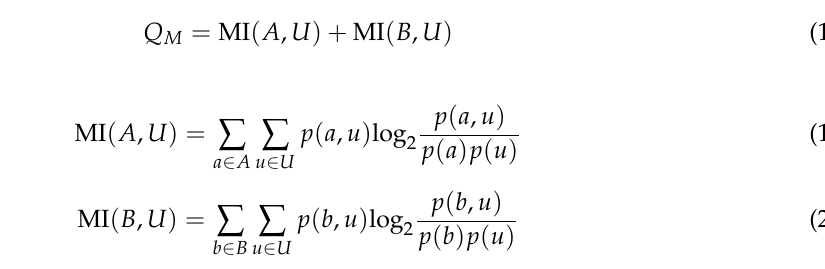
Figure 13. Enlarged views of fused results of ROIs denoted by the red boxes in Groups 7 and 8 shown in Figure 6 for the m-PCNN, SCM-F and SCM-M methods: ( a ) the m-PCNN method for Group 7; ( b ) the SCM-F method for Group 7; ( c ) the SCM-M method for Group 7; ( d ) the m-PCNN method for Group 8; ( e ) the SCM-F method for Group 8; and ( f ) the SCM-M method for Group 8.